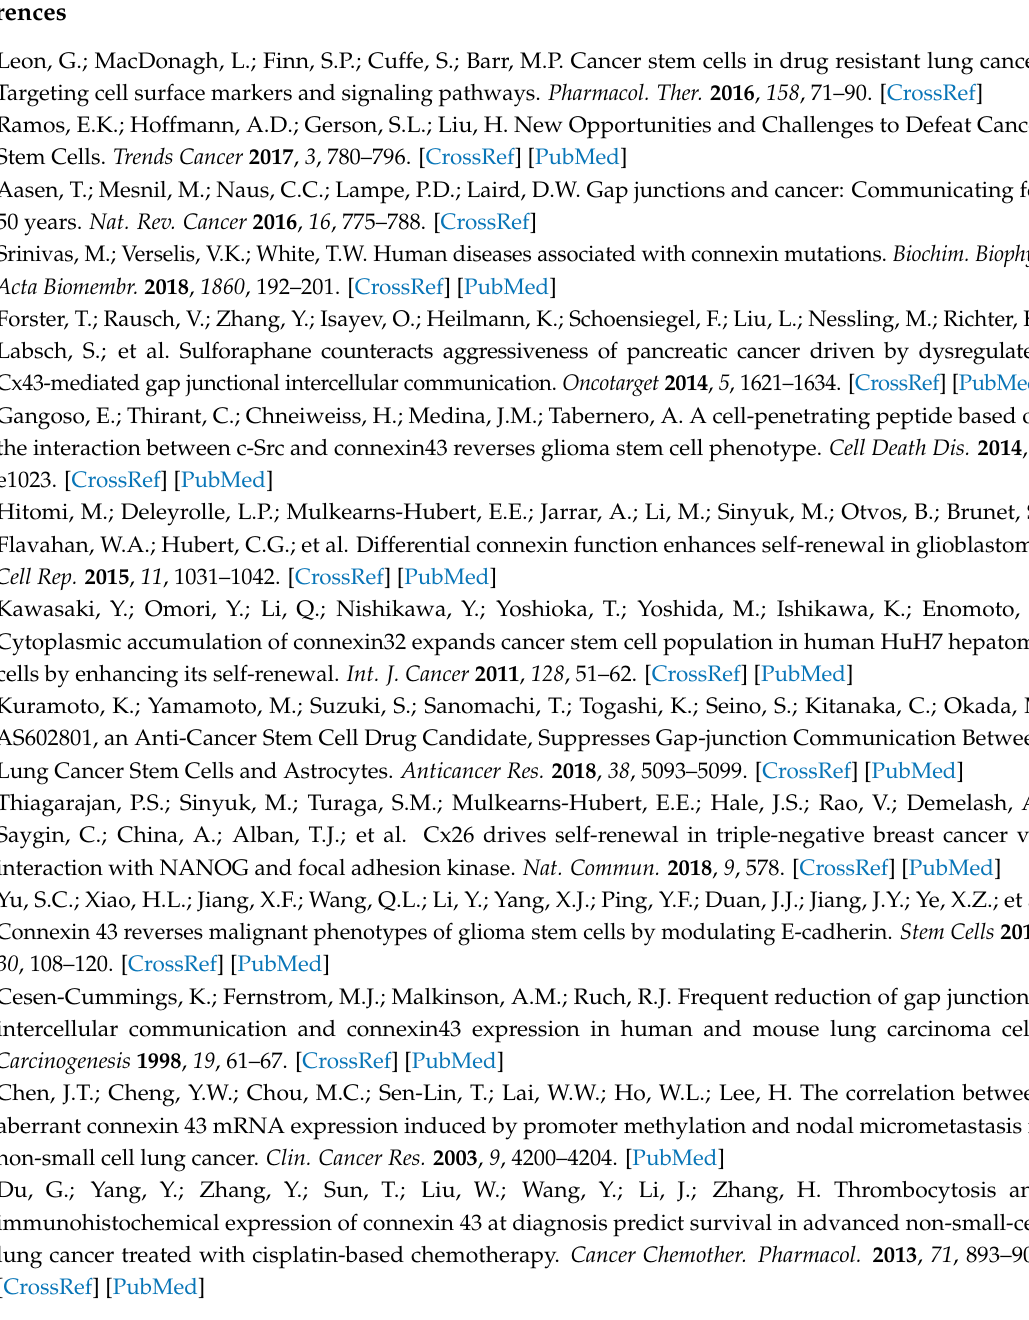
Figure S1: Western blots of Cx26, Cx32, and Cx46 in H125-NEO and H125-CX43 cells and tumorspheres derived from